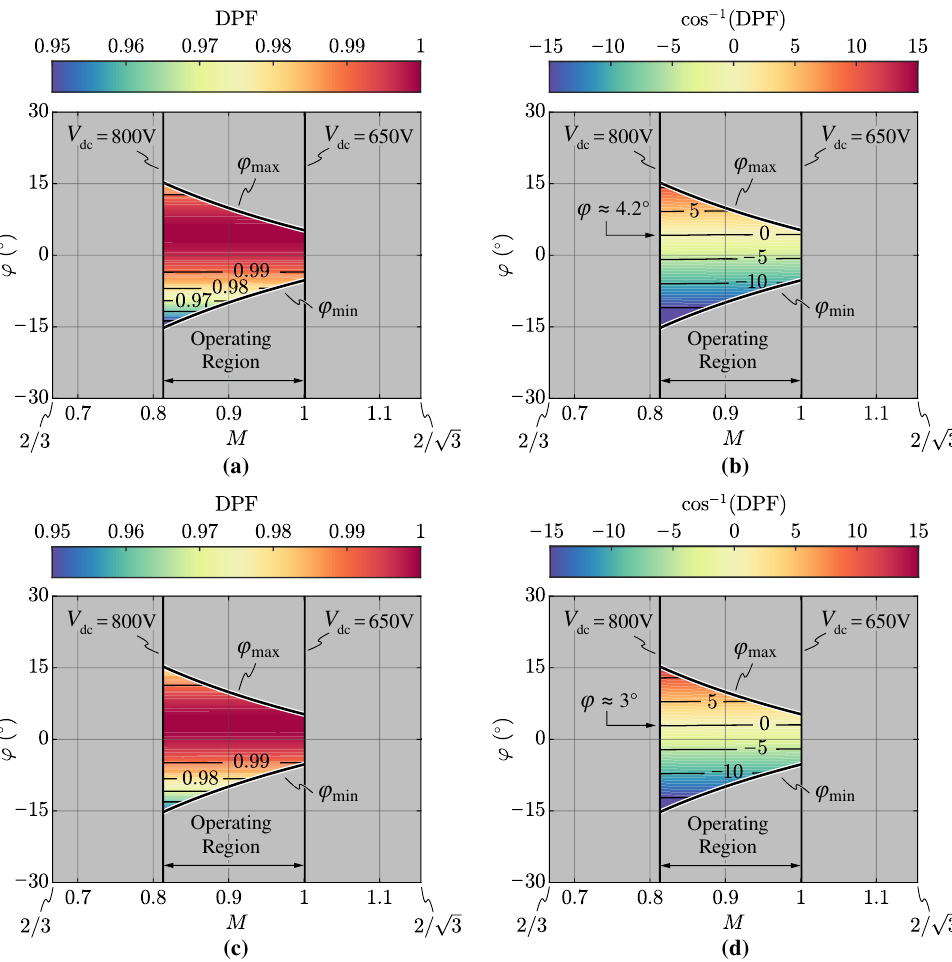
Figure 20. Experimental displacement power factor (DPF) ( a , c ) and DPF angle ( b , d ) for S = 15kVA ( a , b ) and S = 30kVA ( c , d ). The current flowing into the filter capacitor C f is completely compensated for ϕ ≈ 4.2° in ( b ) and ϕ ≈ 3° in ( d